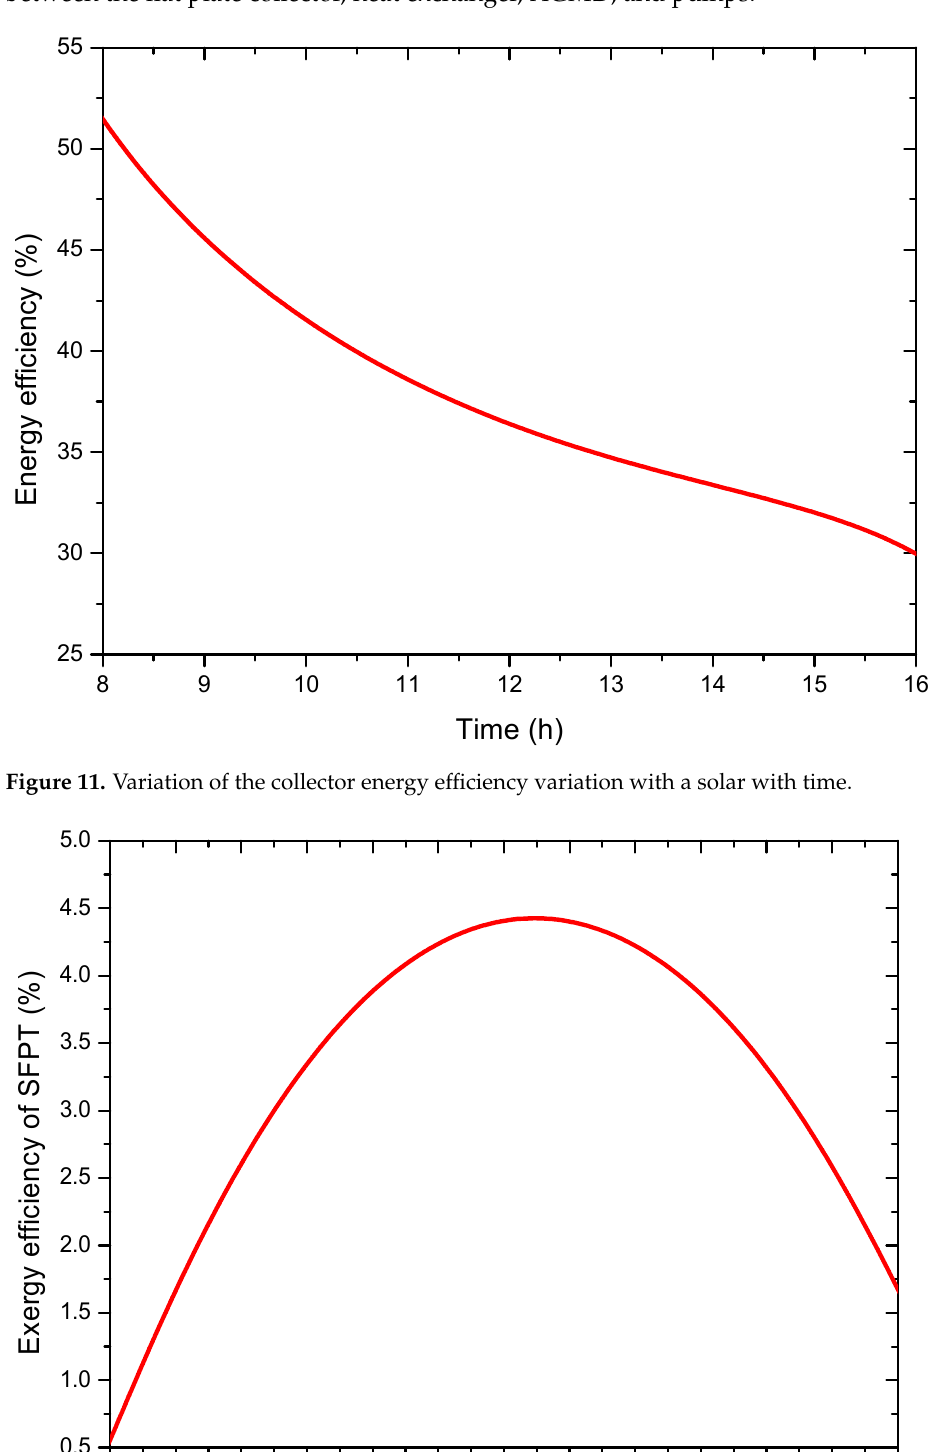
Figure 12. Variation of the collector exergy efficiency variation with a solar with time. 4.5. Maximum Percentage of Component Destruction Exergy The key outcome of the exergy analysis is the identification and quantification of the portions of exergy destroyed in each component. This result enables the measurement and recognition of the exergy loss areas, as well as the target components or sub-systems responsible for inefficiency. Thus, the error is determined. Figure 13 displays the